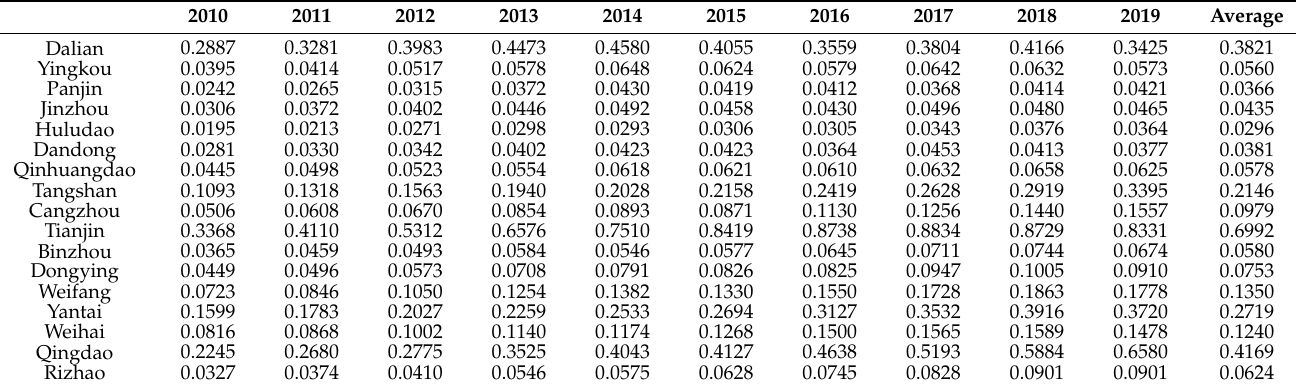
Table 2. Integration capacity values of cities in the Bohai Rim (2010–2019). Source: own elaboration on the basis of a system for assessing the development of a city’s capacity to integrate its marine and terrestrial ecological economies and formula (1), (2), (3),